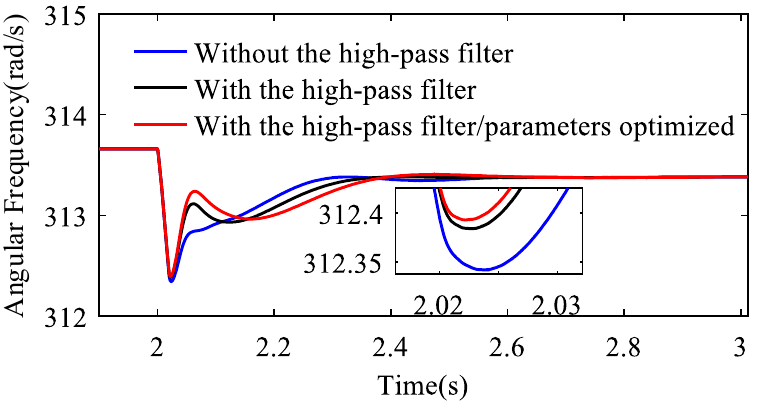
Figure 12. The simulation result of PCC angular frequency in three cases under the condition of load sudden increase.